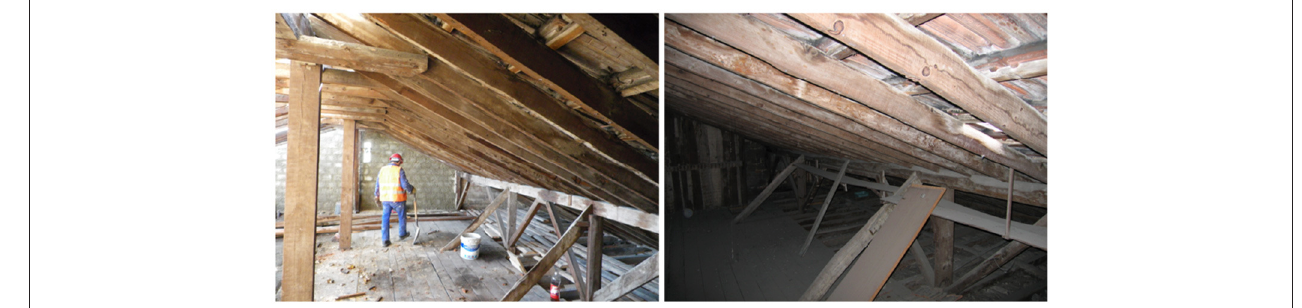
FIGURE 7 | Timber roofs.